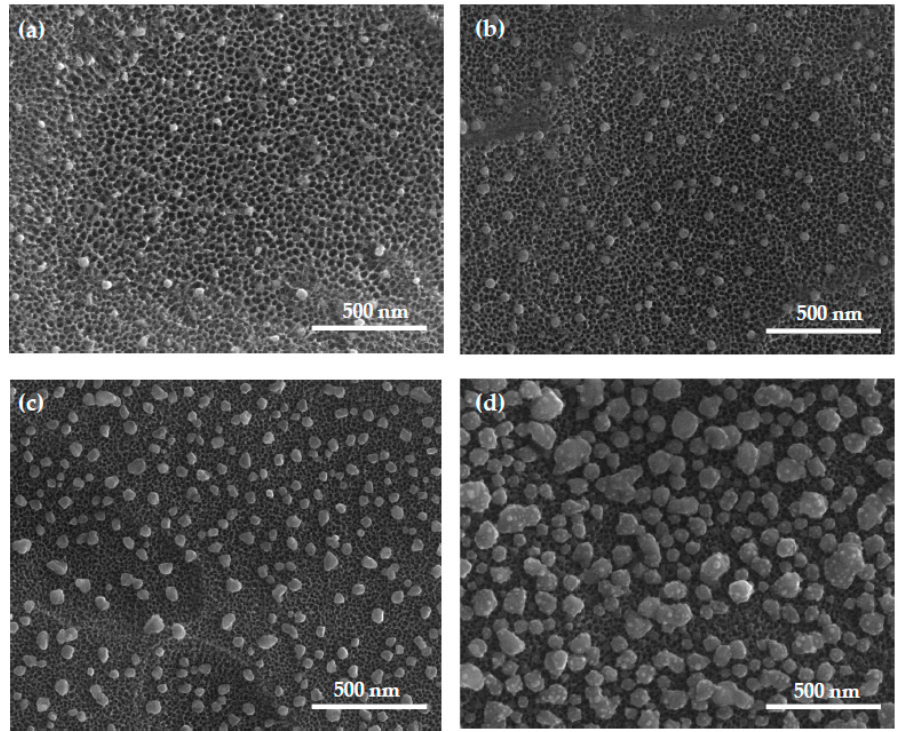
Figure 2. Scanning electron microscopy (SEM) images of Ti6Al4V/TNT5/0.6AgNPs; d = 38 ± 14 nm ( a ), Ti6Al4V/TNT5/1.0AgNPs; d = 43 ± 10 nm ( b ), Ti6Al4V/TNT5/1.6AgNPs; d = 57 ± 24 nm ( c ), Ti6Al4V/TNT5/2.3AgNPs; d = 115 ± 49 nm ( d ).